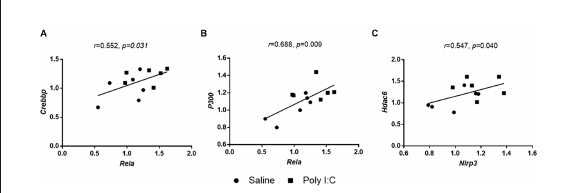
FIGURE6 Correlations between the mRNA expression between (A) Nlrp3 and Hdac6 , (B) Rela and p300 , and (C) Rela and Crebbp